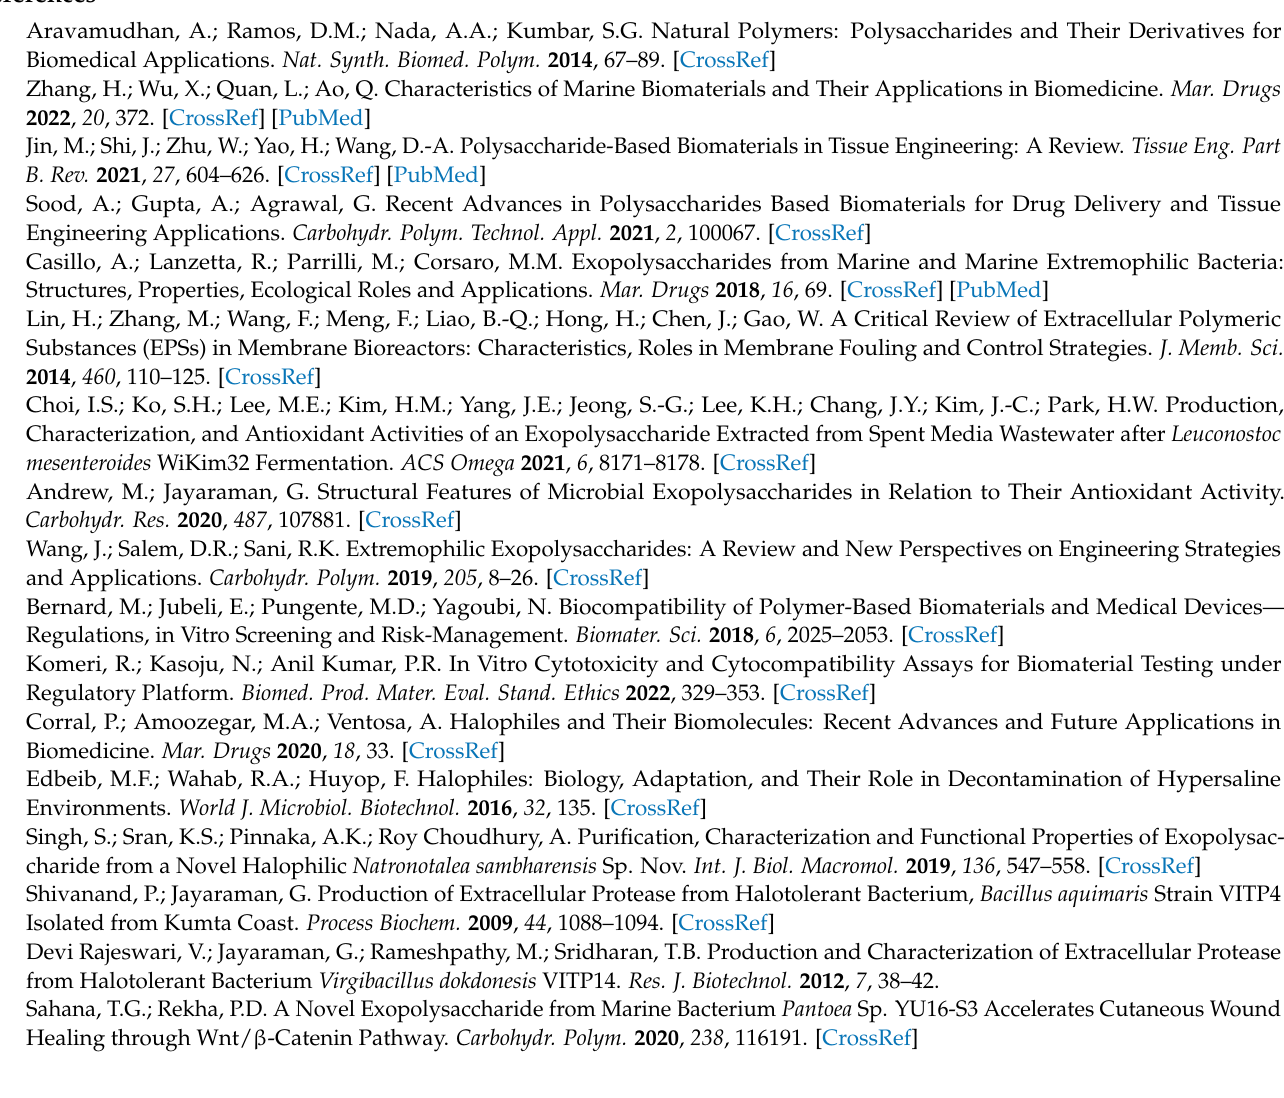
Figure S7: XRD profile of